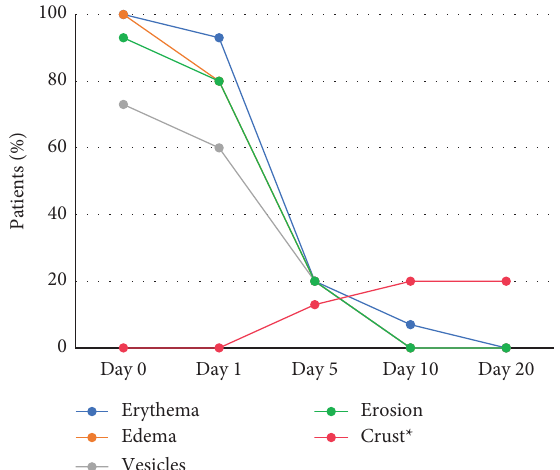
Figure 2: Evolution of the lesion stages during the treatment period of the study for the HSV-2 group (genital herpes). Te chart shows the proportion of patients with a corresponding type of lesion over a period of 20days. ∗ Crust stage includes beginning of crust formation to the crust falling